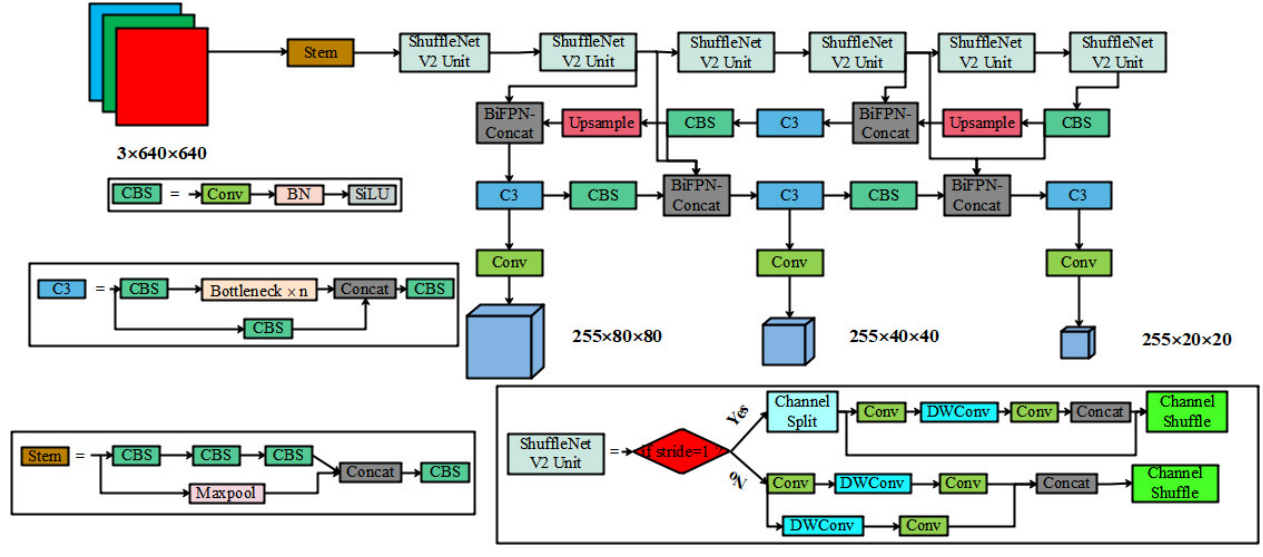
Figure 9. The structure of the improved YOLOv5s model.